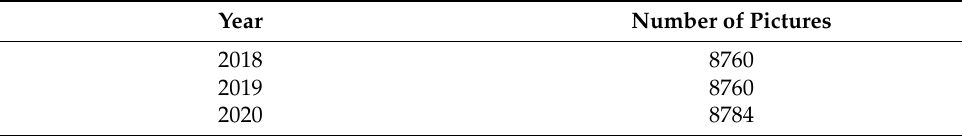
Table 2. Details of the visibility field map